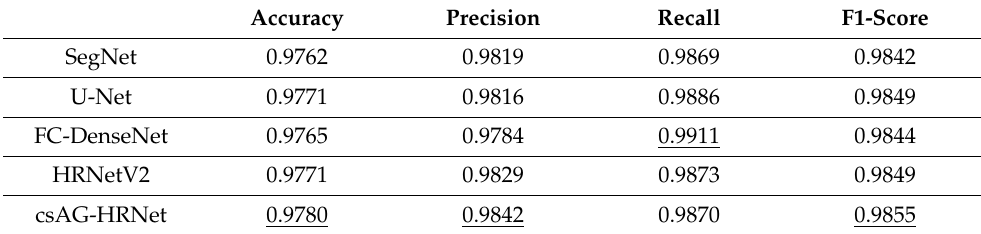
Table 5. Evaluation metrics for each model (WHU